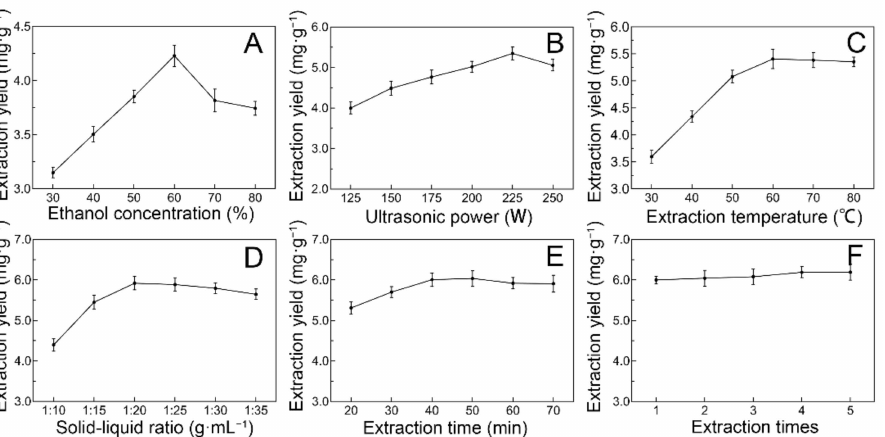
Figure 1. The effects of different ethanol concentration ( A ), ultrasonic power ( B ), extraction tem- perature ( C ), solid–liquid ratio ( D ), extraction time ( E ), extraction times ( F ) on the extraction yield of flavonoids.